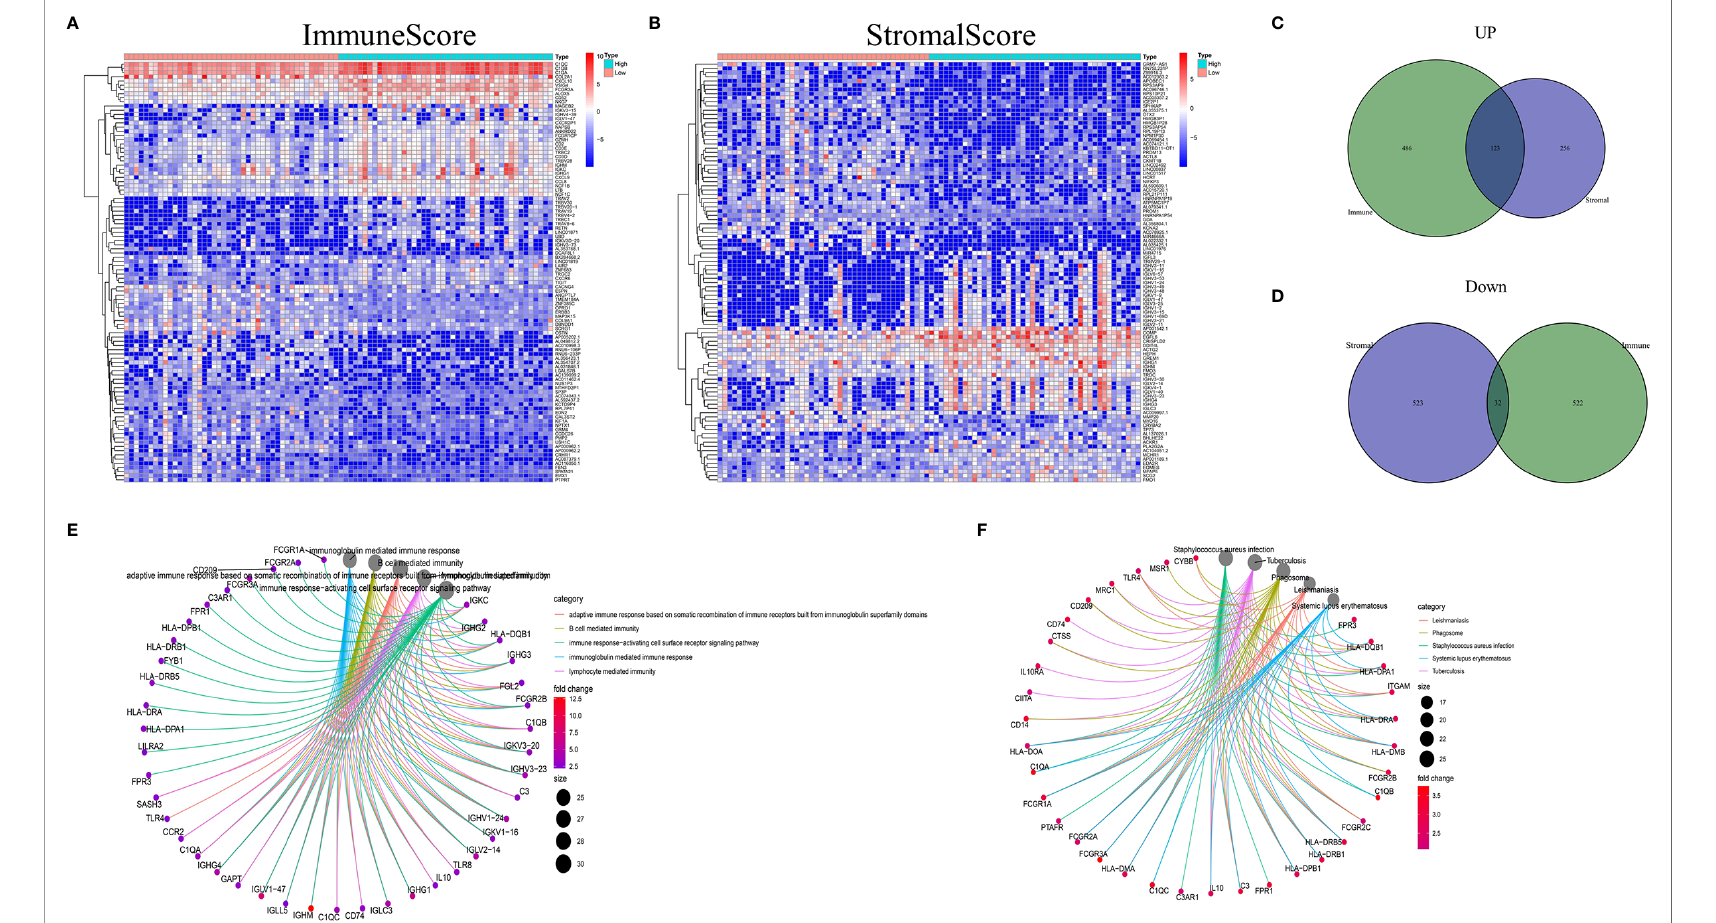
FIGURE 2 | DEG heatmaps, Venn diagrams, and GO and KEGG enrichment analyses. (A) Heatmaps for DEGs identi fi ed by comparing the high-score and low-score ImmuneScore groups. The gene name is shown in the row, and the sample ID (column name) is not shown. The Wilcoxon rank-sum test was used to identify differentially expressed genes, and the threshold of signi fi cance was set at q =0.05 and a fold change after log2 conversion >1. (B) DEG heatmaps, similar to (A) , produced by analysis related to the StromalScore. (C, D) The Venn diagrams displaying the shared up- or downregulated DEGs identi fi ed by the analyses using the ImmuneScore and StromalScore, with a fi ltering threshold of signi fi cance of q <0.05 and a fold change after log2 conversion >1. (E, F) GO and KEGG enrichment analyses were carried out for the 155 DEGs, with p and q <